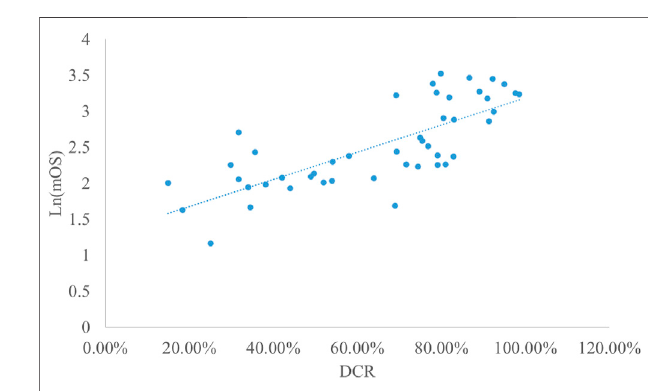
FIGURE 5 | Linear fi tting results for DCR and ln (mPFS).